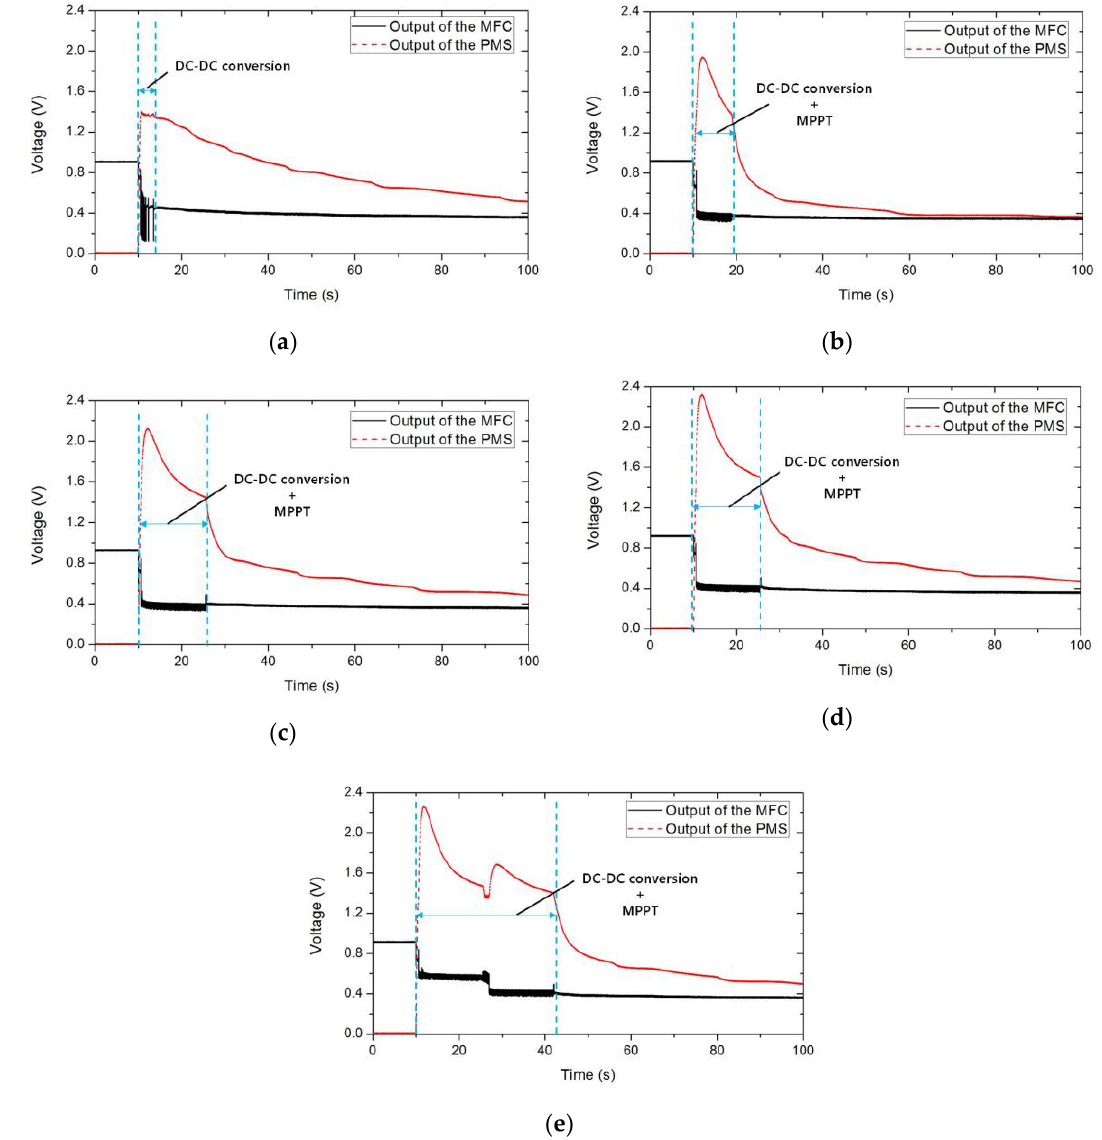
Figure 8. Output voltage of the MFC and PMS at different voltage ratios: ( a ) no MPPT; ( b ) MPPT-20%; ( c ) MPPT-40%; ( d ) MPPT-60%; ( e ) MPPT-80%.